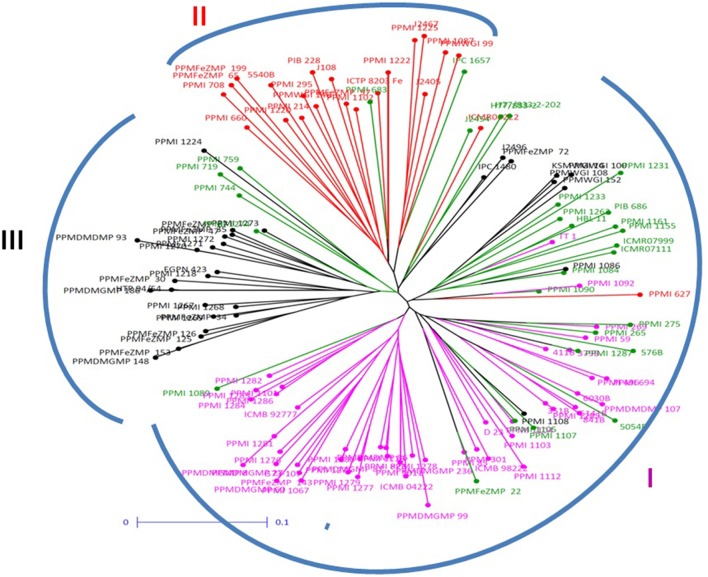
Neighbor joining tree constructed for pearl millet association mapping panel (genotypes represented in different colors corresponding to the three sub-populations and admixture observed in STRUCTURE).